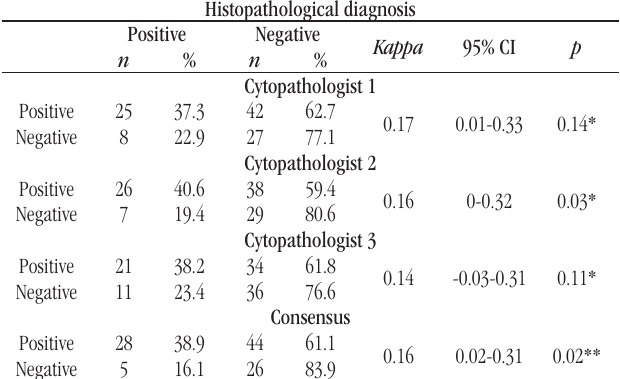
taBLE 4 – Agreement on positive and negative diagnoses among the three cytopathologists, and histopathology in women with cervical neoplasia Histopathological